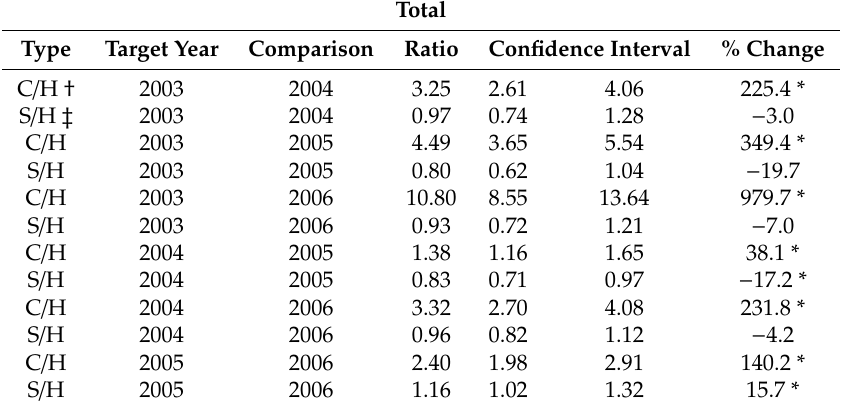
Table 4. Odds ratio estimates for total crosses made at Canal Point, FL; Houma, LA; and St. Gabriel, LA (Louisiana State University, LSU) during 2003–2006. Parental status including intentional